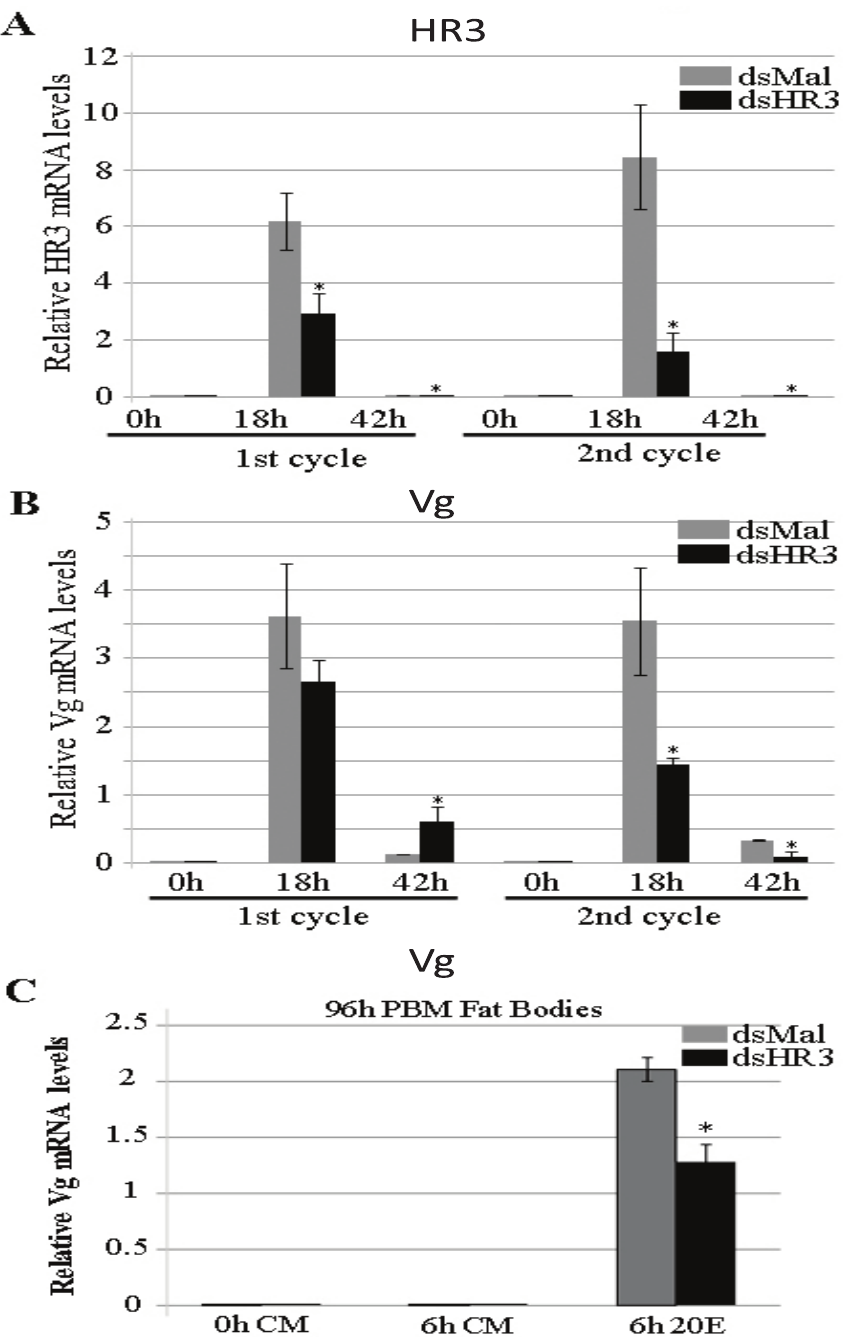
Figure 6. The effect of the HR3 RNAi depletion on transcript abundance of HR3 and Vg in the fat body of Aedes female mosquitoes during the first and second gonadotrophic cycles. Five days after RNAi injection (dsMal as a control or dsHR3), mosquitoes were given a blood meal. Mosquitoes were dissected at the indicated time points as described in Materials and Methods. To study the second vitellogenic cycle, mosquitoes received a second BM 120 h after the first. Each time point represents the average ( 6 SEM) of three groups of three FBs. Each sample was normalized to its internal control ribosomal protein-7 mRNA. Values represent an average of three groups of three FBs. Each experiment was repeated three times ( 6 SEM). *Indicates statistical significance , 0.05. Transcript abundance of HR3 (A) and Vg (B) in FBs in vivo . (C) Fat bodies from Aedes female mosquitoes injected with either dsMal or dsHR3 were dissected 96 h after the first blood feeding. They were incubated for 6 h in the presence (20E) or absence (CM) of 1 microM 20E. Vg relative mRNA levels were measured by means of qPCR. Each time point is the average ( 6 SEM) of three groups of three FBs. Samples were normalized to their internal control ribosomal protein-7 mRNA. The experiment was repeated three times with different cohorts of mosquitoes. *Indicates statistical significance , 0.05.